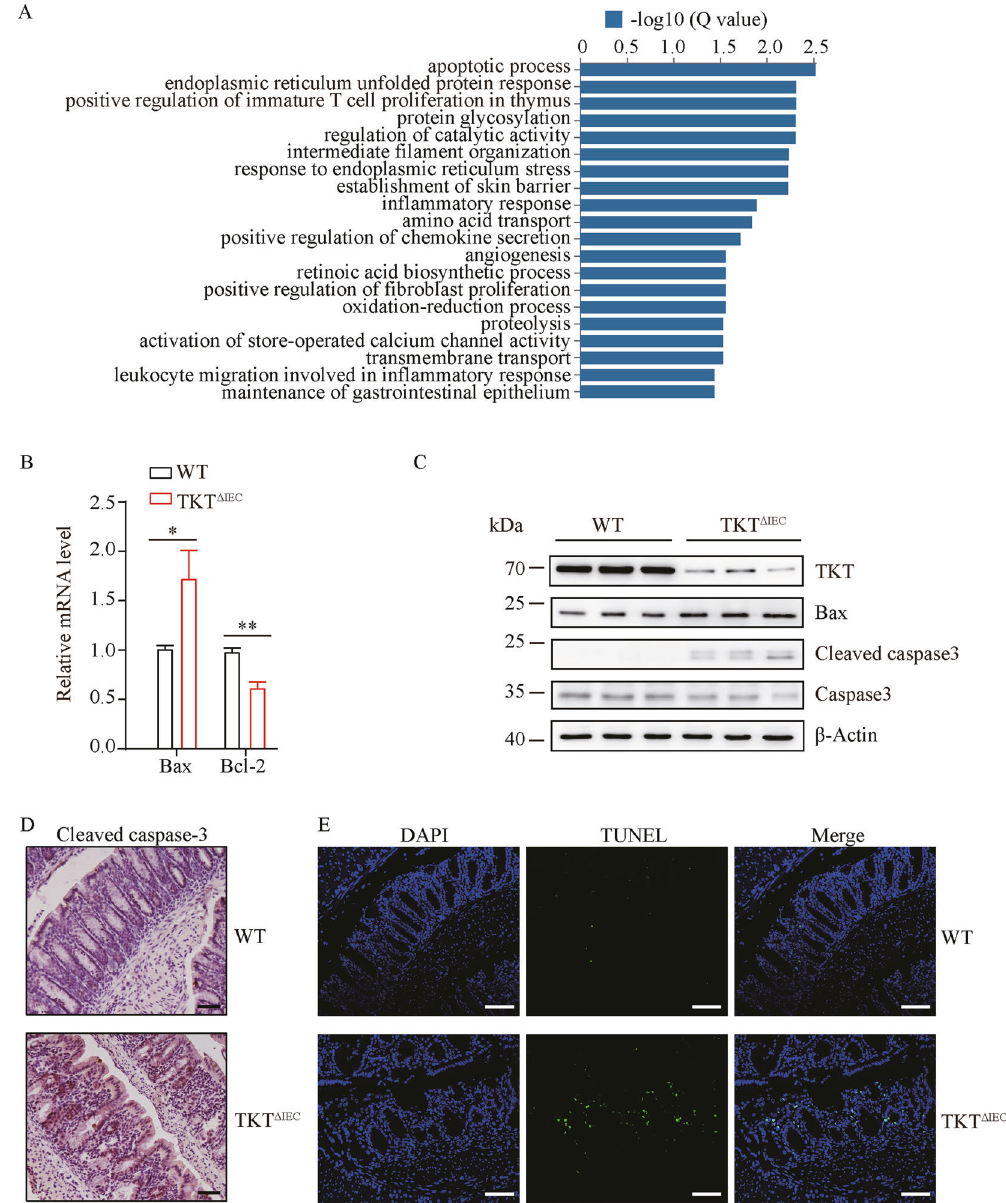
lysates were analyzed by western blotting (one mouse per lane) with the indicated antibodies from 3-week-old WT and TKT Δ IEC mice. D Representative images of colon sections stained with the cleaved caspase-3 antibody from 3-week-old WT and TKT Δ IEC mice. Scale bars, 50 μ m. E Representative images of TUNEL-stained colon sections of 3-week-old WT and TKT Δ IEC mice. Scale bars, 75 μ m. Data are represented as mean ± SEM. Signi fi cance is determined by Student ’ s t test analysis, * P < 0.05, ** P < 0.01, *** P <